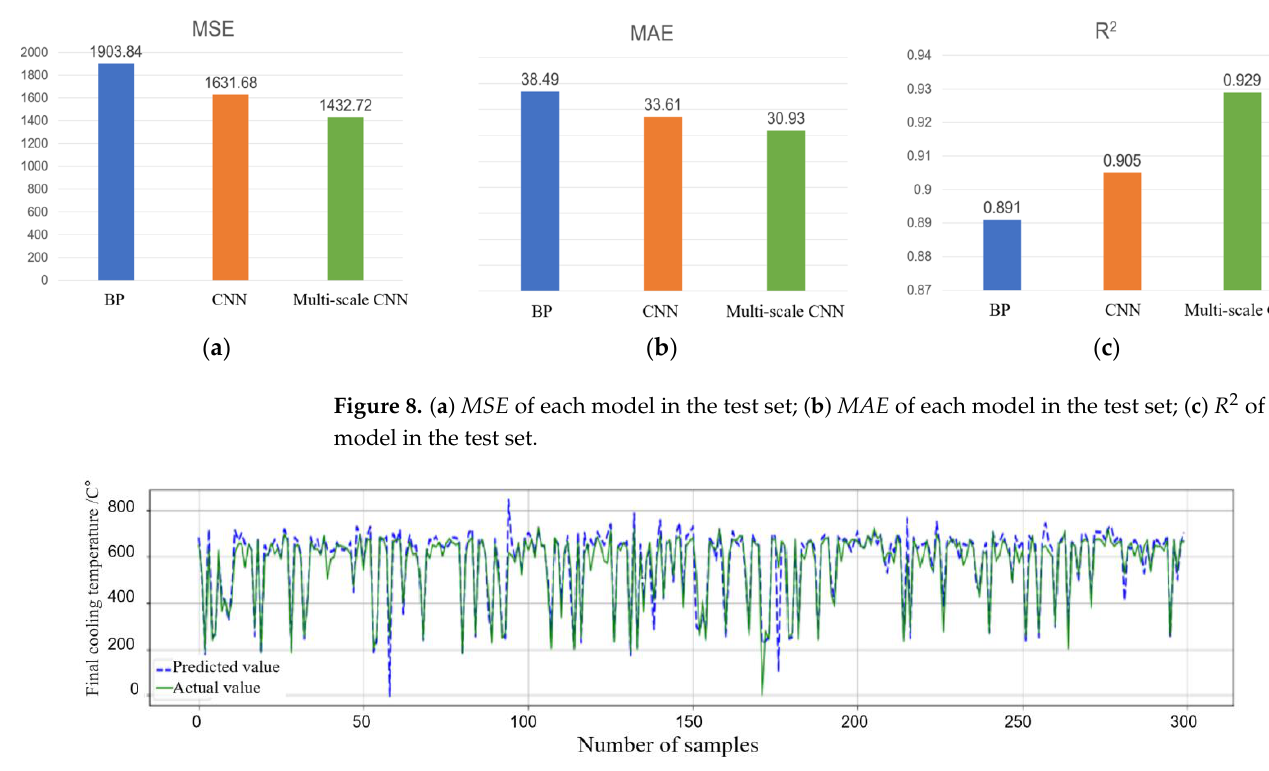
Figure 7. ( a ) Relative error between the predicted value and actual value of BP neural network in the test set; ( b ) relative error between the predicted value and actual value of convolutional neural network in the test set; ( c ) relative error between the predicted value and actual value of multi-scale convolutional neural network in the test set.